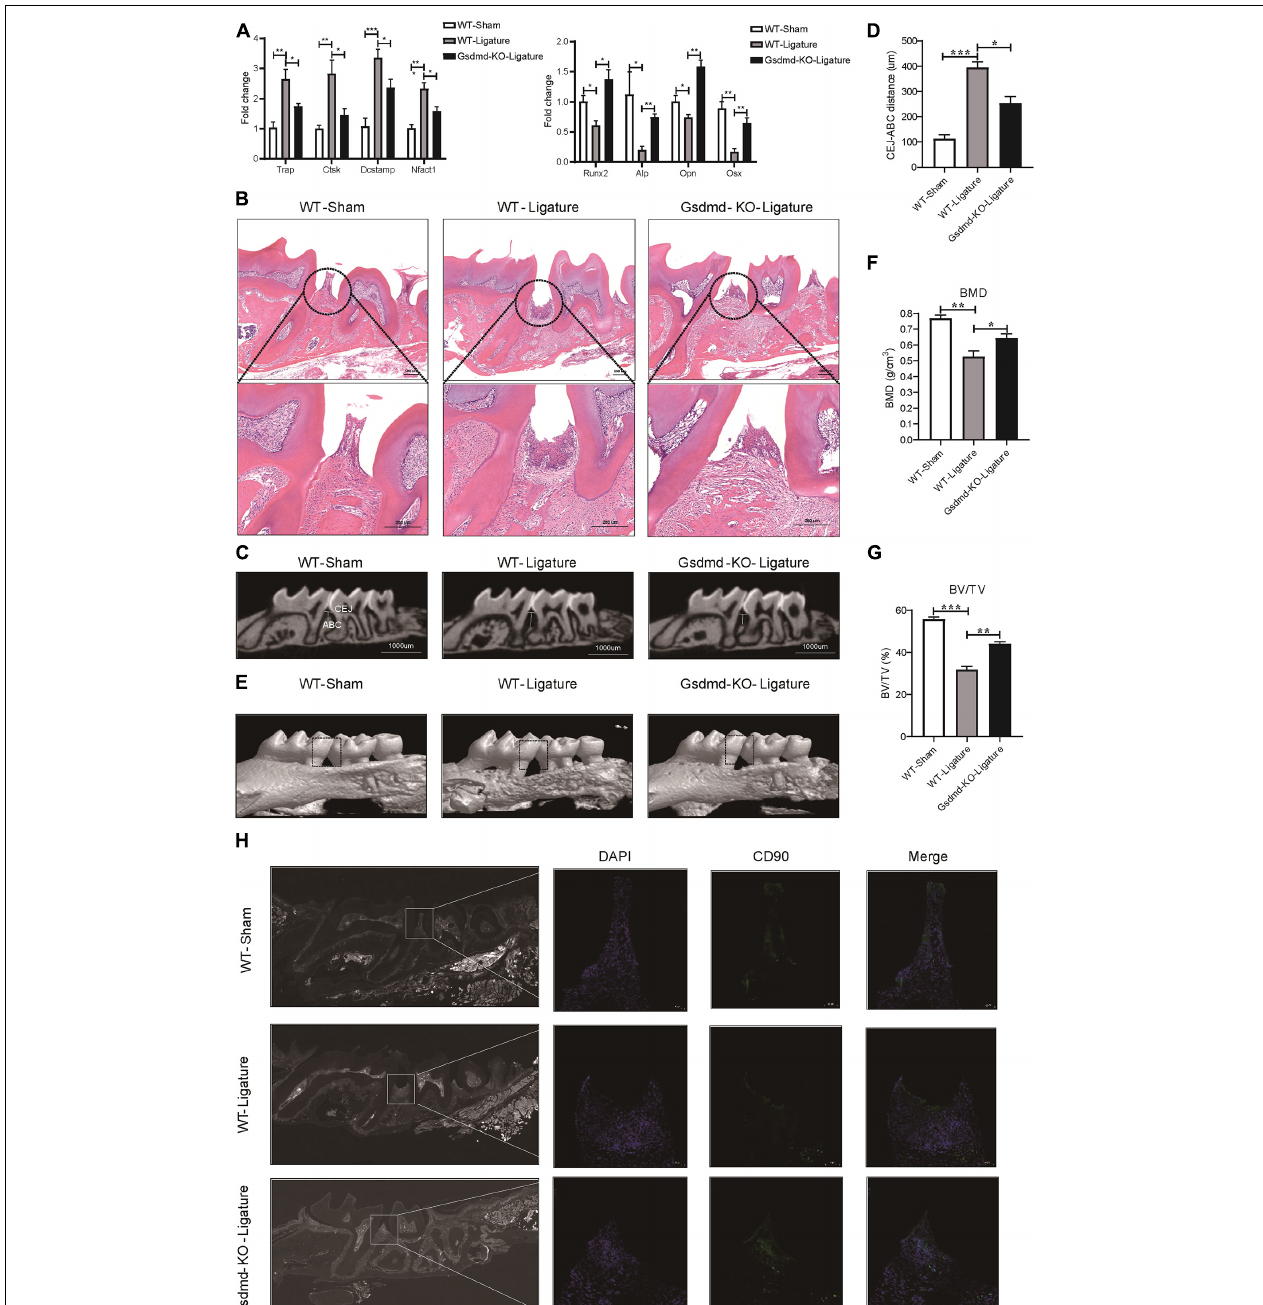
FIGURE 7 | Gsdmd –/– mice presented with reduced periodontal inflammation and bone loss in experimental periodontitis. (A–H) Mice were divided into the WT-sham group, WT-ligature group, and Gsdmd-KO-ligature group. Silk thread was used to form a ligature around the left maxillary first molar for 2 weeks to induce periodontitis. (A) Periodontium tissues were collected from each group, and the mRNA expression of osteoblast markers (including Runx2 , Alp , Opn, and Osx ) and osteoclast markers (including Trap , Ctsk , Dcstamp, and Nfact1 ) was analyzed by real-time PCR. 36b4 was used as an internal control. (B) Tissue sections from mice were prepared after 14 days of periodontitis induction and processed for hematoxylin and eosin (H&E) staining. (C) Representative micro-CT sagittal images of maxillary molars after insertion of ligature. CEJ, cement-enamel junction; ABC, alveolar bone crest. The line indicates the distance from the CEJ to the ABC on the buccal side of the ligature site. (D) The distances ( µ m) between CEJ and ABC were measured after periodontitis induction. (E) The images of bone surrounding first molars were analyzed by 3D micro-computed tomography. The squares formed by the continuous dotted line show visual differences in alveolar bone from animal groups. The bone mineral density (F) and bone/tissue volume (G) of the selected square regions on the ligature site were calculated. (H) Immunofluorescence staining of CD90 (green) in mouse maxillary molar longitudinal sections from the periodontitis model and sham group. Nuclei were identified by staining with DAPI. Scale bars, 50 µ m. The data are presented as the mean ± SEM. * P < 0.05, ** P < 0.01, *** P < 0.001.